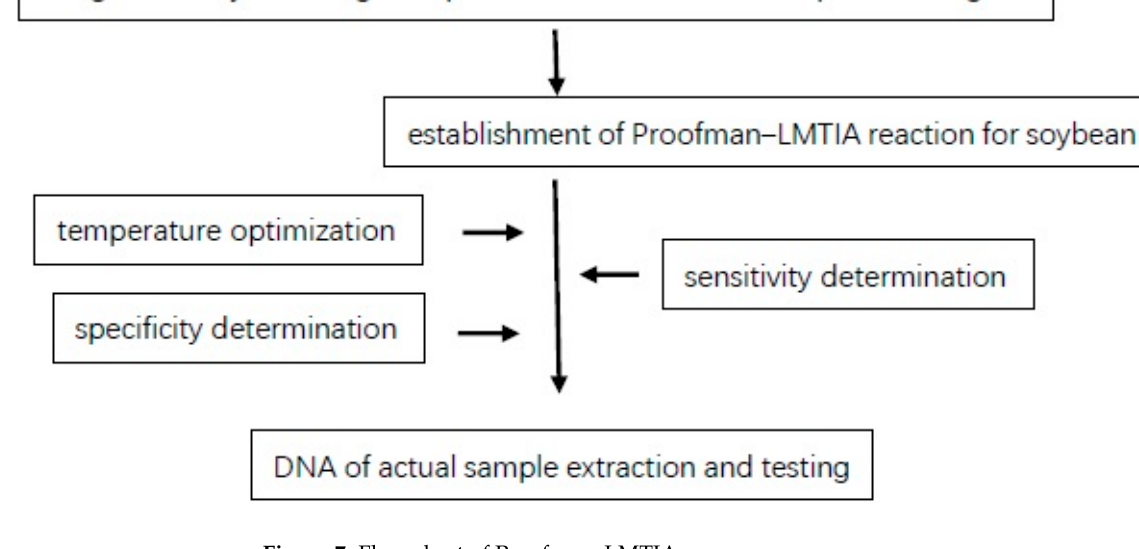
Figure 7. Flow chart of Proofman–LMTIA.